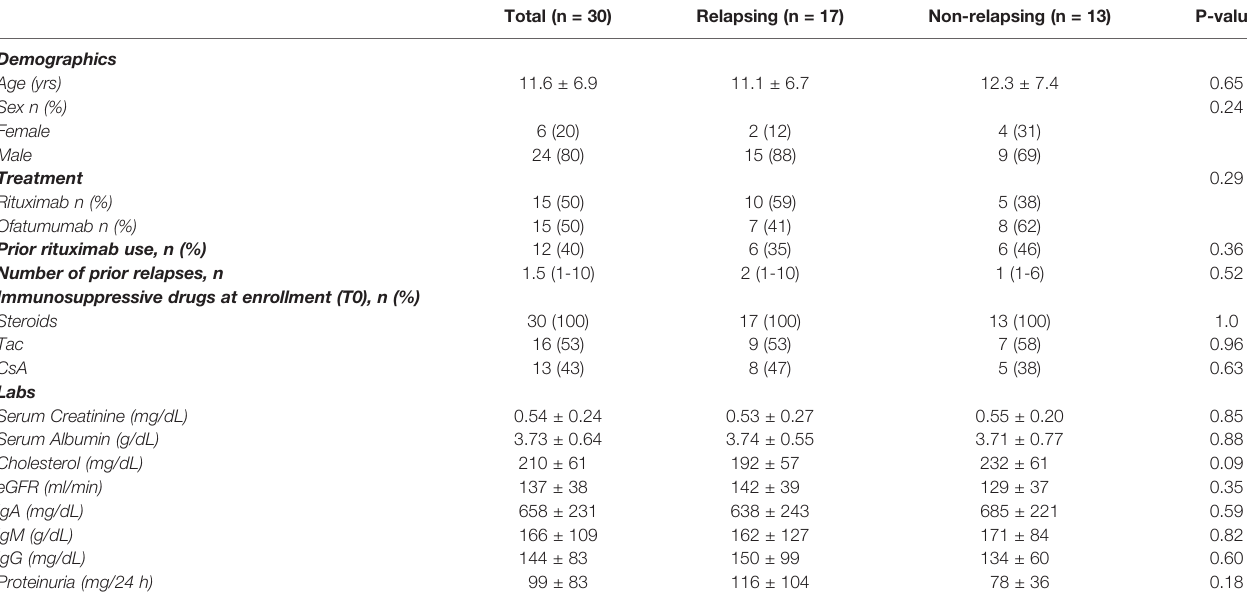
TABLE 1 | Baseline characteristics of study